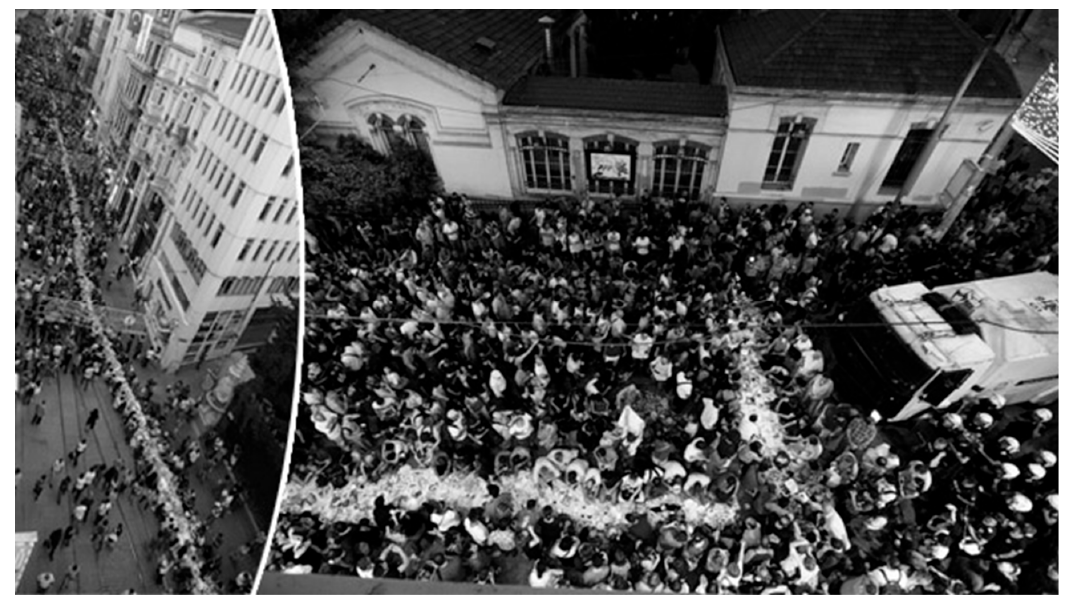
Figure 1. Iftar on Earth. July 7 2013, Istanbul [source: unknown].